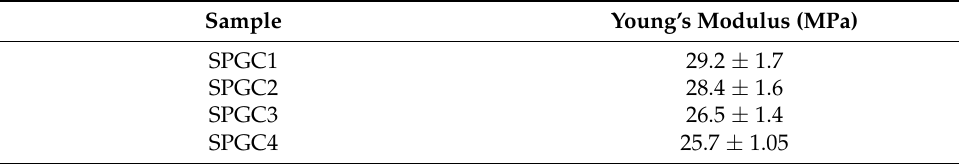
Figure 2. The effects of various citric acid proportions (0.46, 0.92, 1.38, and 1.83 wt%) on the film elongation-at-break percentage. Table 2. Young’s moduli of the samples.